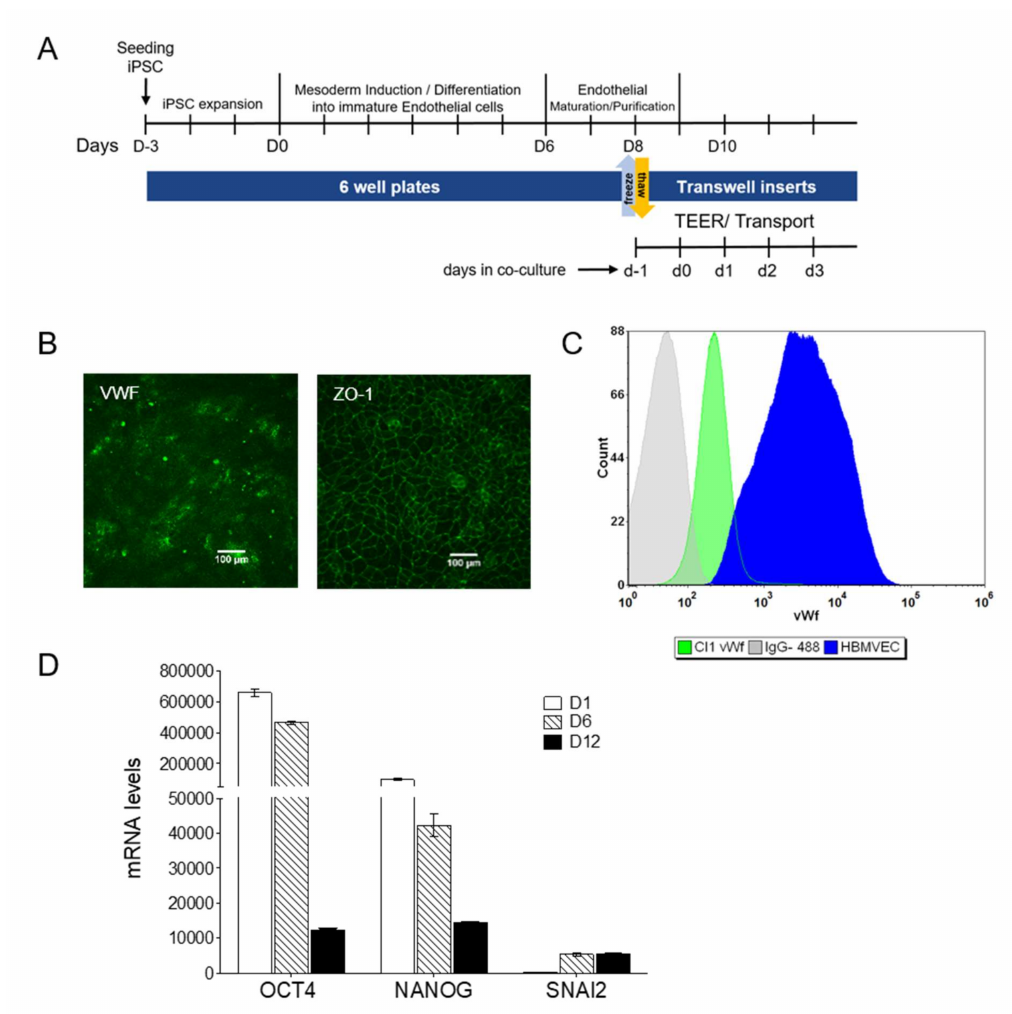
Figure 2. Generation and selection of hiPSC-derived BMECs. ( A ) Scheme illustrating the timeline and the cell culture steps. ( B ) Immunostaining of VWF and ZO-1 at D8. Scale bar represented 100 µ m. ( C ) Representative flow cytometry analysis of VWF in endothelial progenitors at D8 and HBMVEC cells, used as positive control. The corresponding isotype control was also included. ( D ) Mesodermal transition: mRNA levels for pluripotency and the mesoderm specific marker SNAI2 measured during di ff erentiation. Results (as mean ± sd) are from a representative experiment performed on biological duplicates, each with two technical